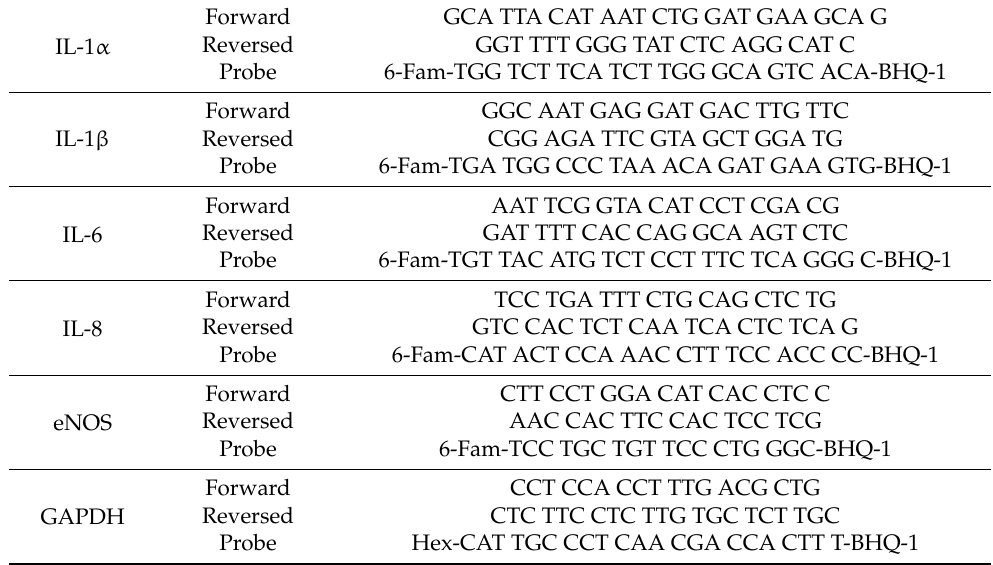
Table 2. Primers used in qPCR